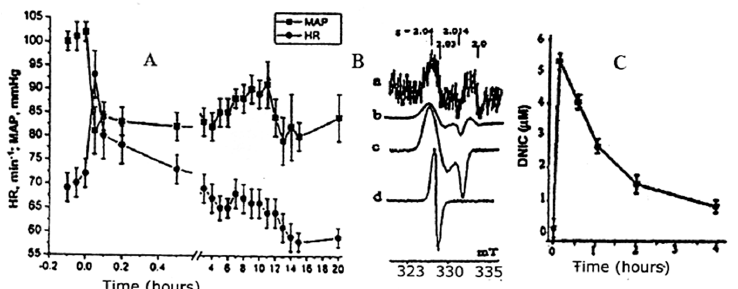
Figure 26. ( A ): Effects of Oxacom (3 mg/kg or 0.1 µ M/kg of DNIC-GS respectively) on mean arterial pressure (MAP) and heart rate (HR) of healthy male volunteers. ( B ): EPR signals of DNIC in the blood of healthy volunteers (a,b) and in solutions of M-DNICs with glutathione (c,d). Recordings were made at ambient temperature (a,d) or at 77K (b,c). ( C ): Pharmacokinetics of DNIC in human venous blood (M ± m, n = 14) [7]. (With